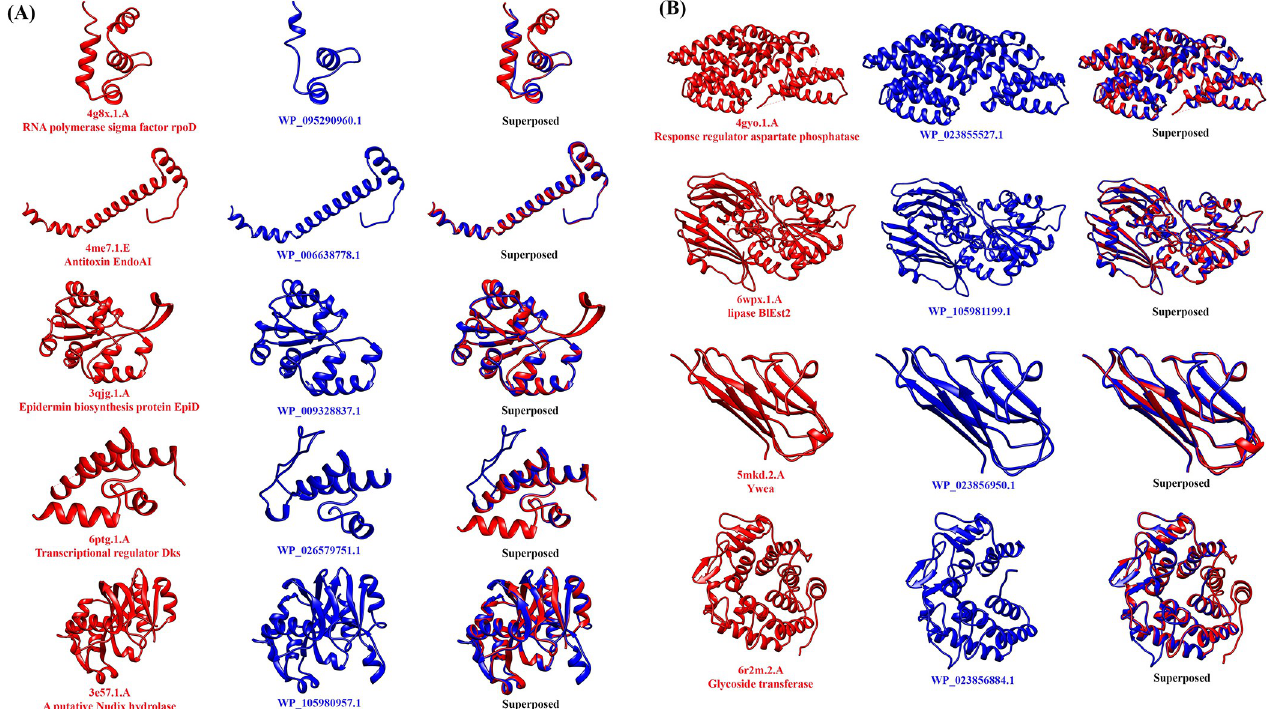
Fig 3. A & B. Tertiary structures analysis. Three-dimensional structures were modeled by the SWISS-MODEL server reliably using the templates with higher coverage, more than 30% of identity, and higher GMQE scores along with Ramachandran Favored percentages � 90%. Only the templates determined by the X-ray crystallography with high resolution were used. The known proteins and the modeled structures are indicated in red and blue colors respectively. The proteins are orientated using the Chimera MatchMaker according to the optimal superposition of the matching